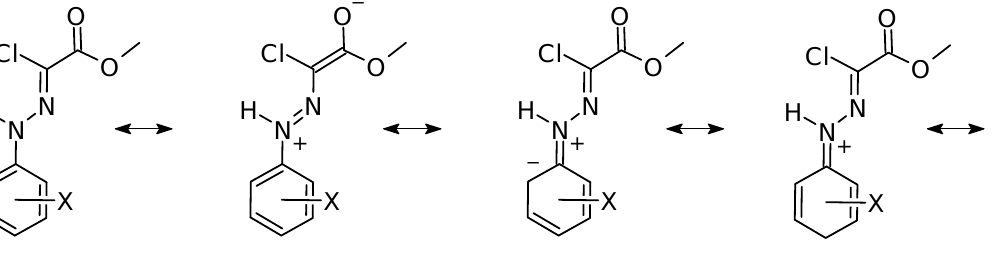
with electron conjugation between the aryl and hydrazonic moieties. electron conjugation between the aryl and hydrazonic moieties.